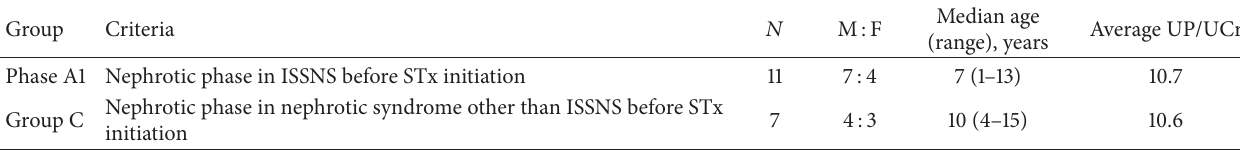
Table 2: Characteristics of groups analyzed for serum apolipoprotein C-I.